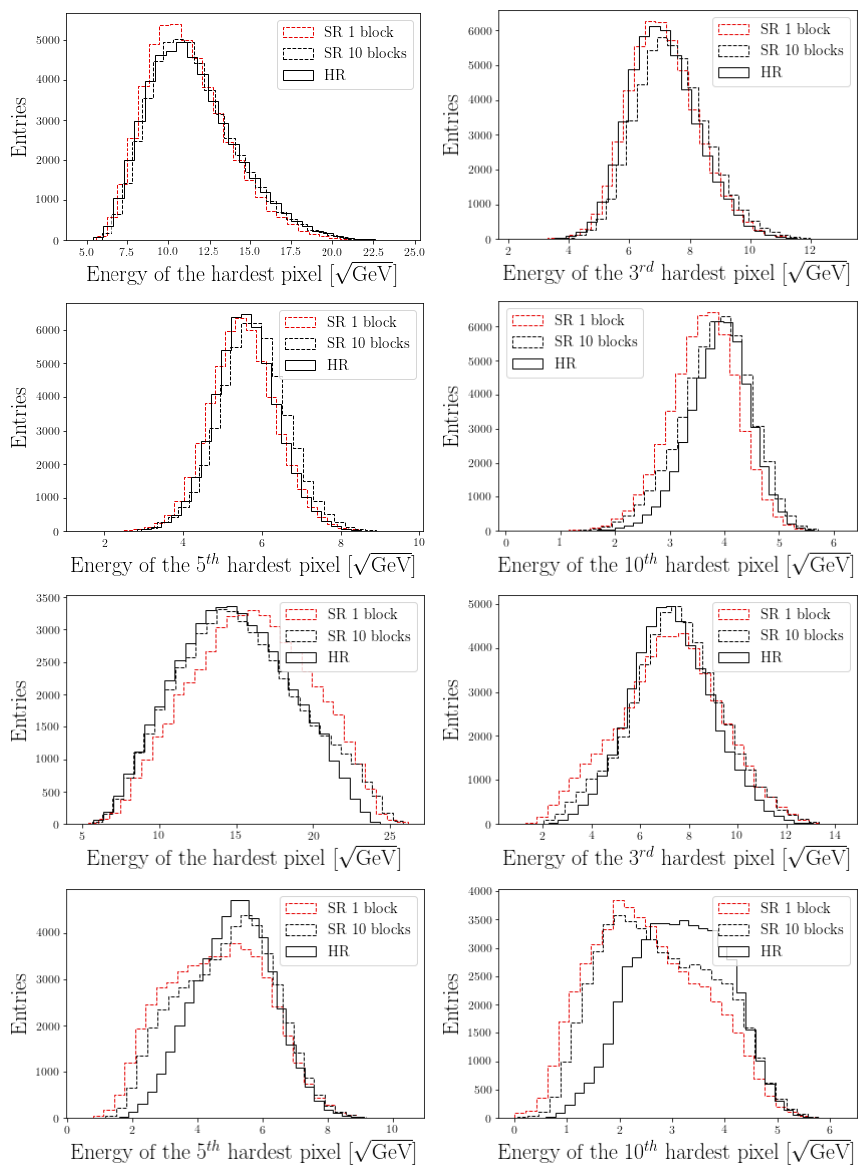
Figure 10: Demonstration of the performance of a reduced complexity (1 RRDB block) network compared to a more complex network (10 RRDB blocks), for net- works trained on and applied top-quark jets (upper) and QCD jets (lower). Shown are distributions of the square-root of the pixel energies for the true high resolution image (HR) and super resolution images generated by the reduced and standard complexity